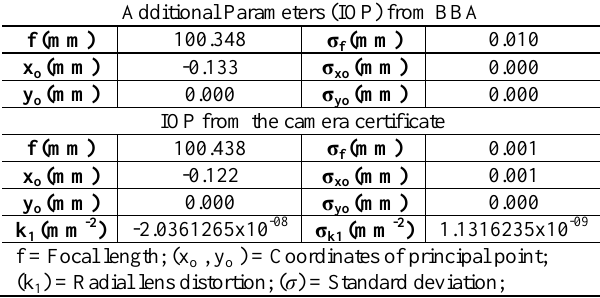
Table 2. Estimated IOP from the in situ camera calibration and nominal IOP values from the camera